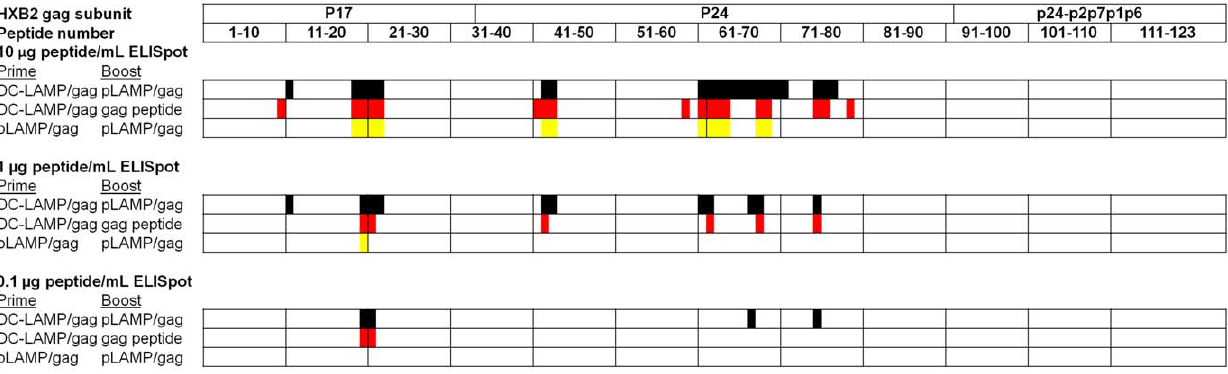
Figure 2. Peptide specificity and relative avidity of IFN- c -secreting HIV-1 Gag-specific CD4 T-cell responses in HLA-DR4 (DRB1*0401) Tg mice immunized with pLAMP/gag-based formulations. Mice were immunized subcutaneously with 50 m g pLAMP/gag plasmid DNA or with 1 6 10 5 pLAMP-1/gag-transfected immature DCs (DC-LAMP/gag), and boosted with pLAMP/gag plasmid DNA (lower and upper lines) or Gag peptides (middle line). Gag peptide-specific CD4 T cell responses were measured by IFN- c ELISpot assay using CD8-depleted splenocytes, at peptide concentration of 10 m g/ml (top), 1 m g/ml (middle), and 0.1 m g/ml (bottom). The domain structure of the HIV-1 Gag polyprotein is indicated on the top, and the corresponding overlapping peptides are numbered below. Peptides eliciting positive ELISpot responses in mice immunized with pLAMP/gag plasmid DNA prime/boost (yellow), DC-LAMP/gag prime and Gag peptide boost (red), and DC-LAMP/gag prime and plasmid DNA boost (black) are indicated